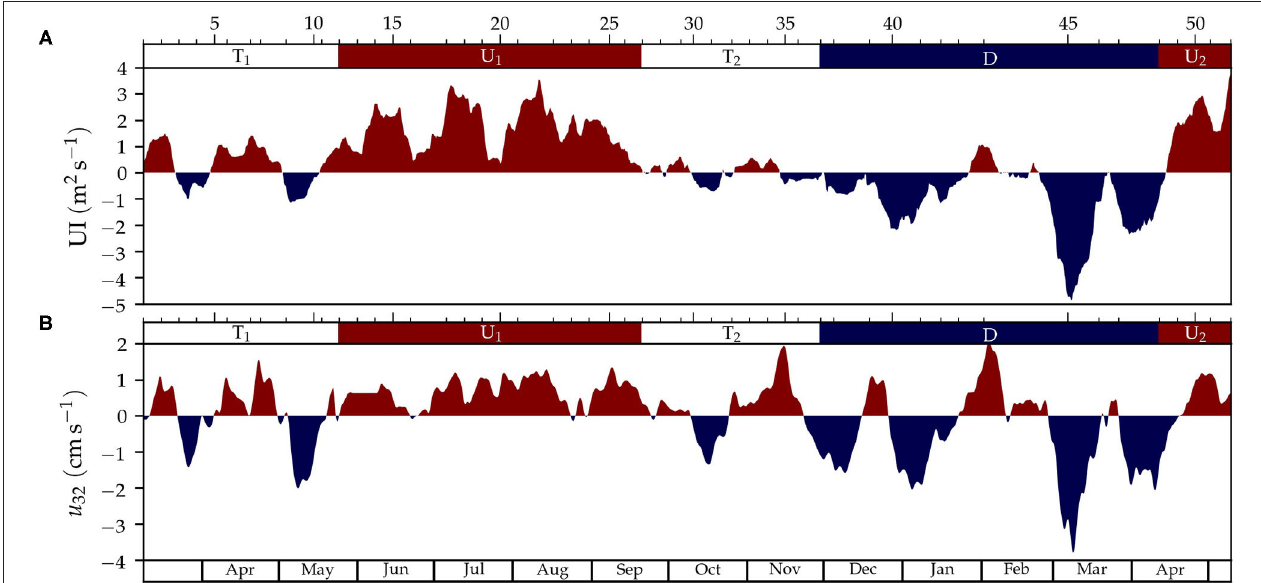
FIGURE 2 | Time-series of fortnight moving average of (A) the upwelling index (UI) and (B) along-Ría residual current velocity at 32 meters depth ( u 32 ). The sign of UI and u 32 is marked with red color for positive values (upwelling, deep flow into the Ría) and blue for negative (downwelling, deep flow out of the Ría). The ticks and numbers on the top axis indicate the sampling number and the colors, the periods for upwelling (U 1 and U 2 , in red), downwelling (D, in blue), and transition (T 1 and T 2 , in